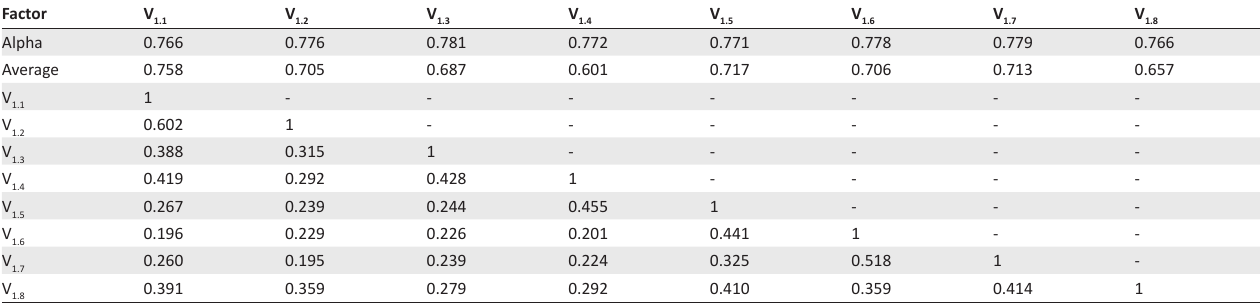
TABLE 10: Comparison of Cronbach’s alpha and AVE across leadership construct. Factor